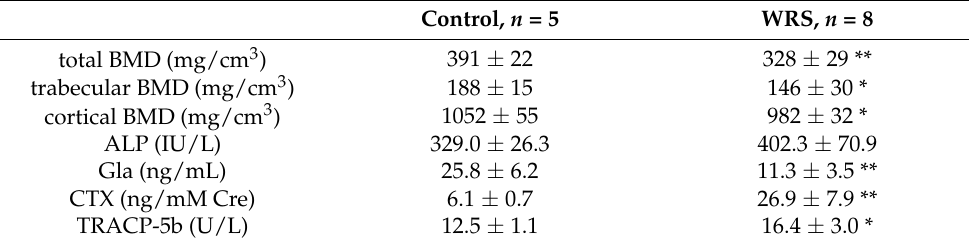
Table 3. Influence of WRS on BMD and bone turnover markers.